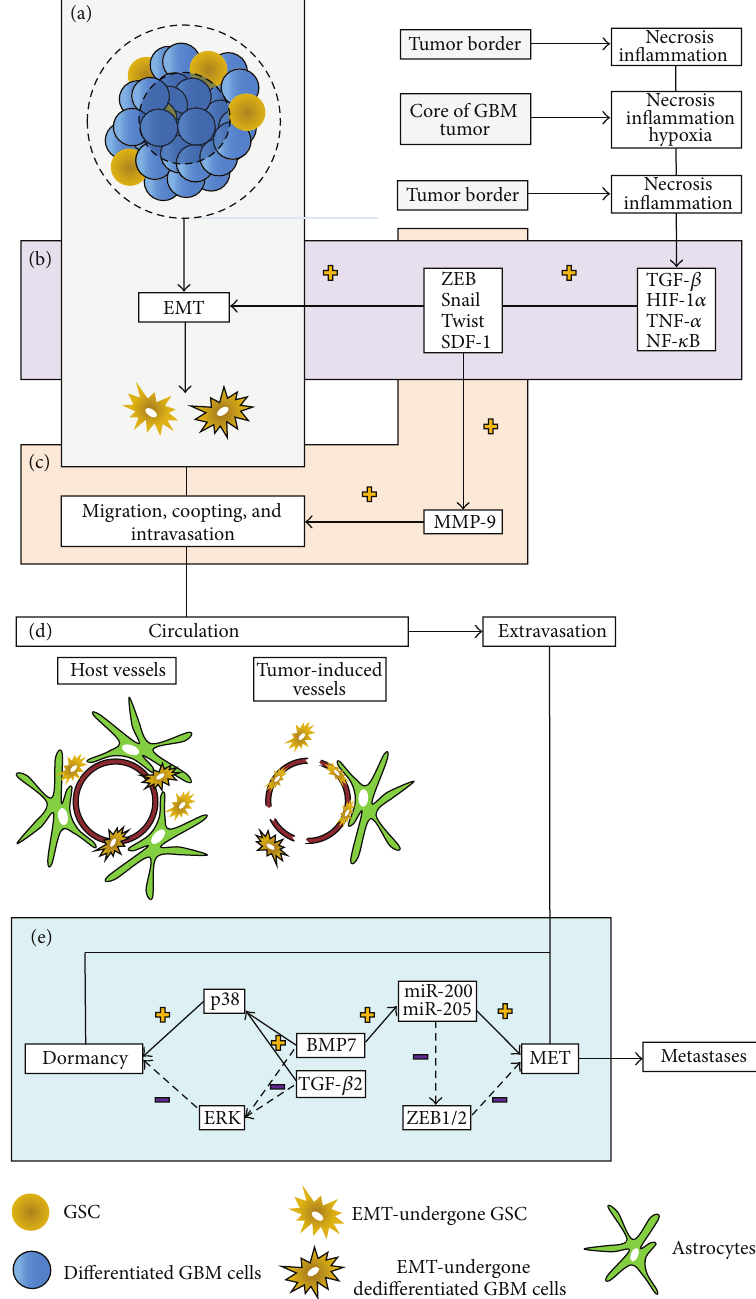
Figure 1: Insights on GBM dissemination process. Both GSC and differentiated cells can undergo EMT in order to invade the brain parenchyma. This process is regulated by different transcription factors including ZEB, SNAIL, Twist, or NF- 𝜅 B that are activated upon several environmental conditions (inflammation, necrosis, and hypoxia) ((a) and (b)). This consequently results in the acquisition of mesenchymal properties and the expression of ECM degrading enzymes in order to favor tumor spread. This process also sustains intravasation, leading to systemic dissemination ((c) and (d)). Tumor blood vessels are usually incomplete and leaky, therefore favoring intra-/extravasation (d). In pathological conditions, the BBB is often disrupted, facilitating GBM cells to jump in the blood flow as well (d). When tumor cells extravasate, they may either become quiescent or develop metastases. This balance is tightly regulated by environmental conditions and factors including BMP7 or TGF 𝛽 2 among many others which may induce either dormancy or a switch toward MET and metastases